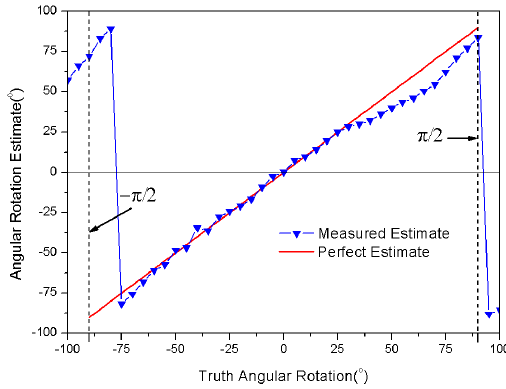
Figure 9. Comparison between measured and perfect estimated tilt angle.